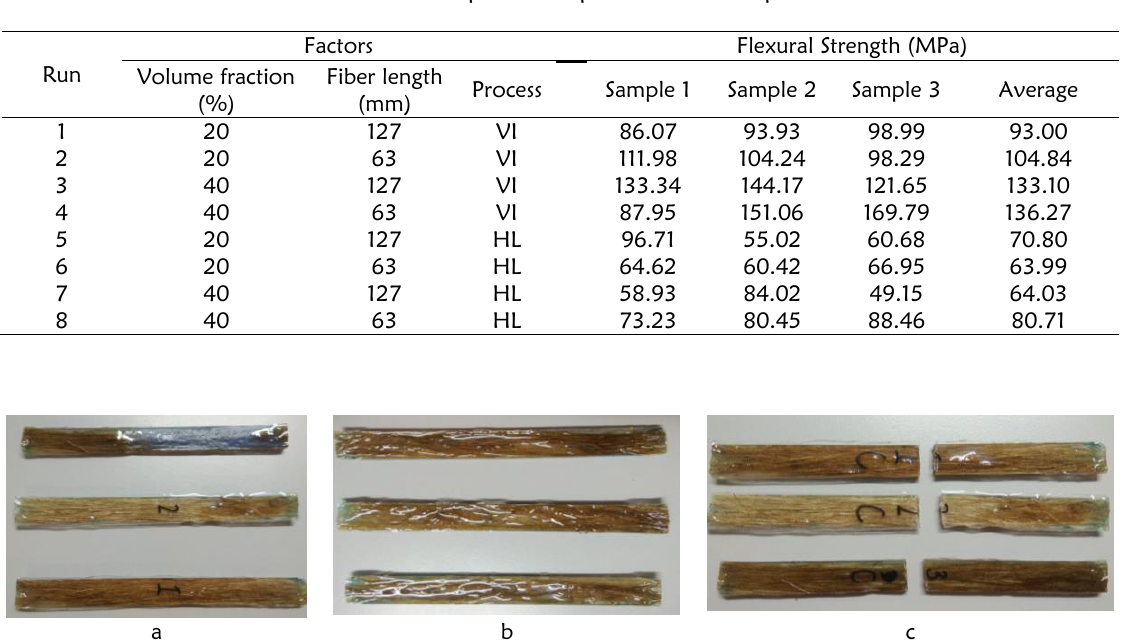
Table 1: Experimental parameters and responses